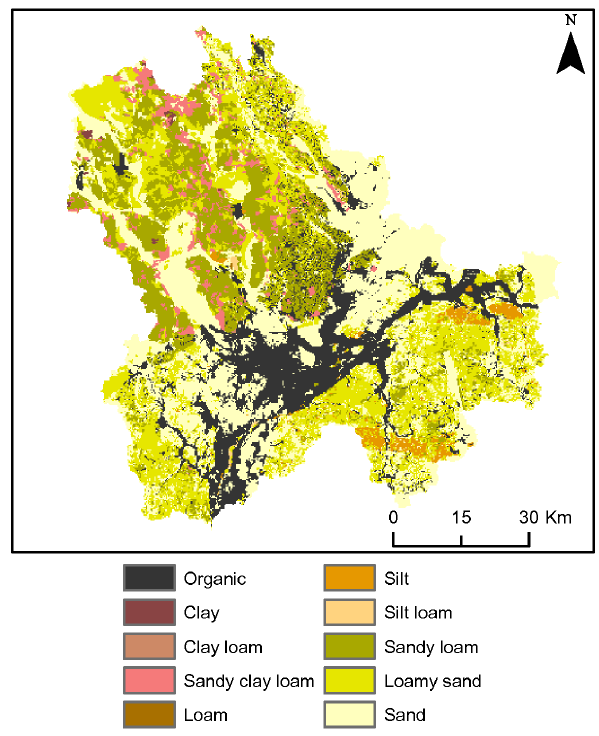
Figure 4. Soil texture map of the study area. Soil textures are the same as used in the WetSpa model, defined by the US Department of